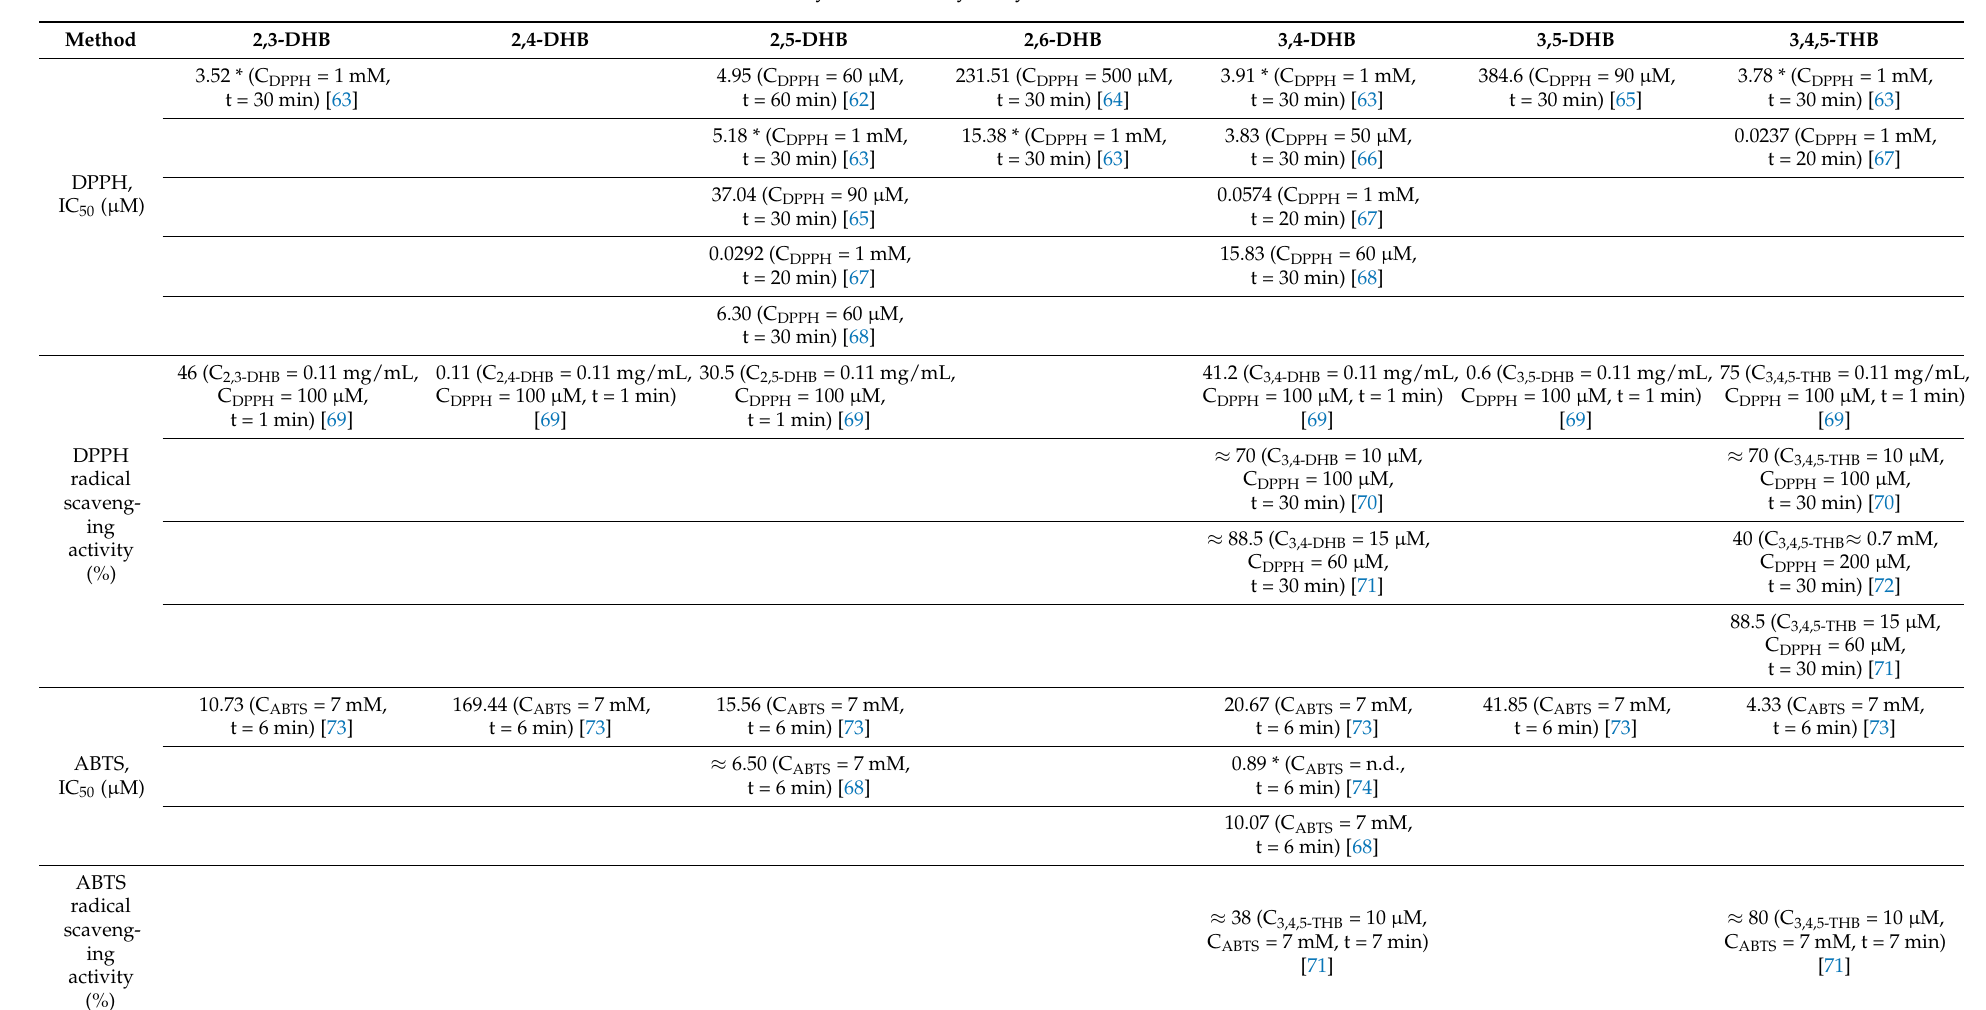
Table 2. Antioxidant activity of selected hydroxybenzoic acids on the basis of literature